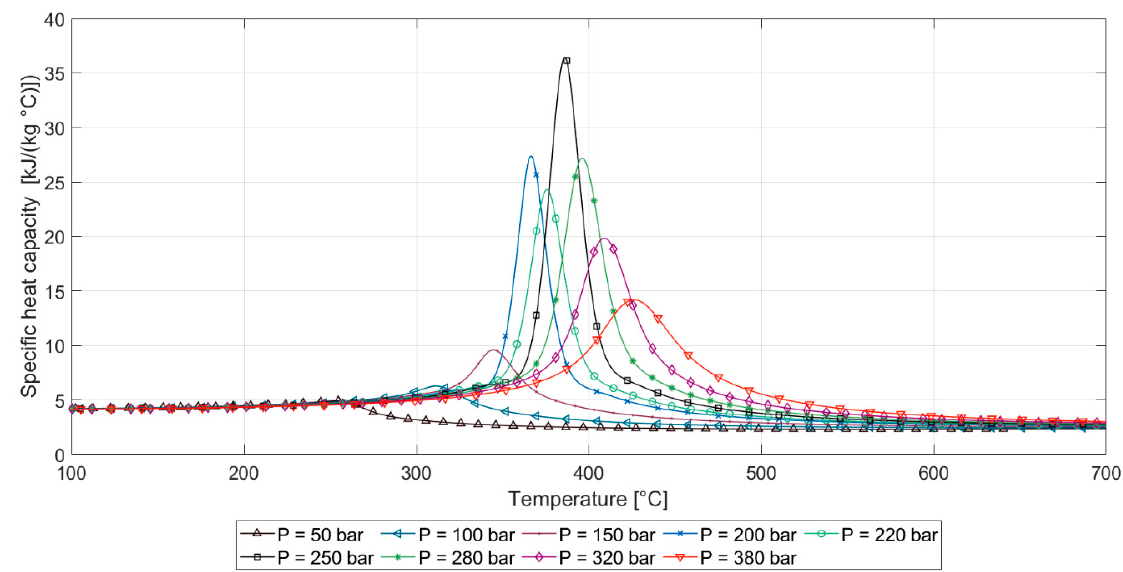
Figure 7. Specific heat capacity of water at diverse pressures against temperature. Derived from the NIST Standard Steam Tables [43].